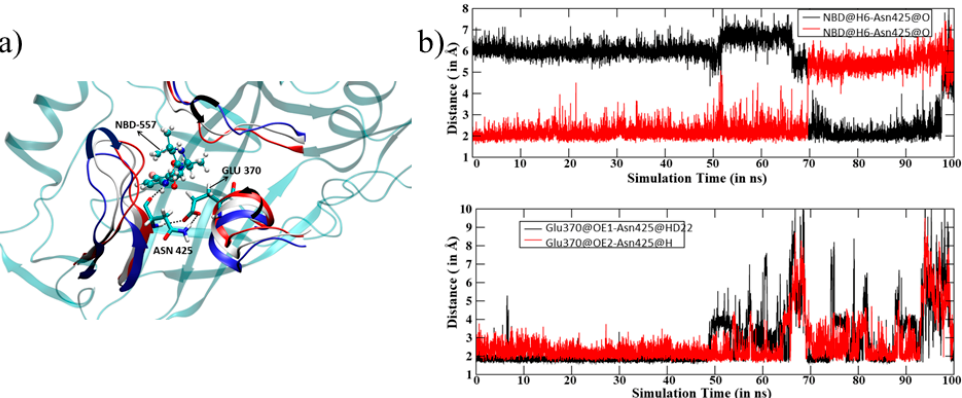
Figure 3. ( a ) Key residues interacting with NBD-557. Notice the movement of structural motifs surrounding ligand indicated by arrows (blue represents initial, white shows mid and red shows the orientations at the last step of MD simulations. ( b ) The distance vs. simulation time for 100 ns of MD simulation for key H-bonds (top) and the distance between Glu370 and Asn425 (bottom). Note a constant and strong interaction of NBD-557 with Asn425. Note that all results are reported for the most populated trajectories of 100 ns.